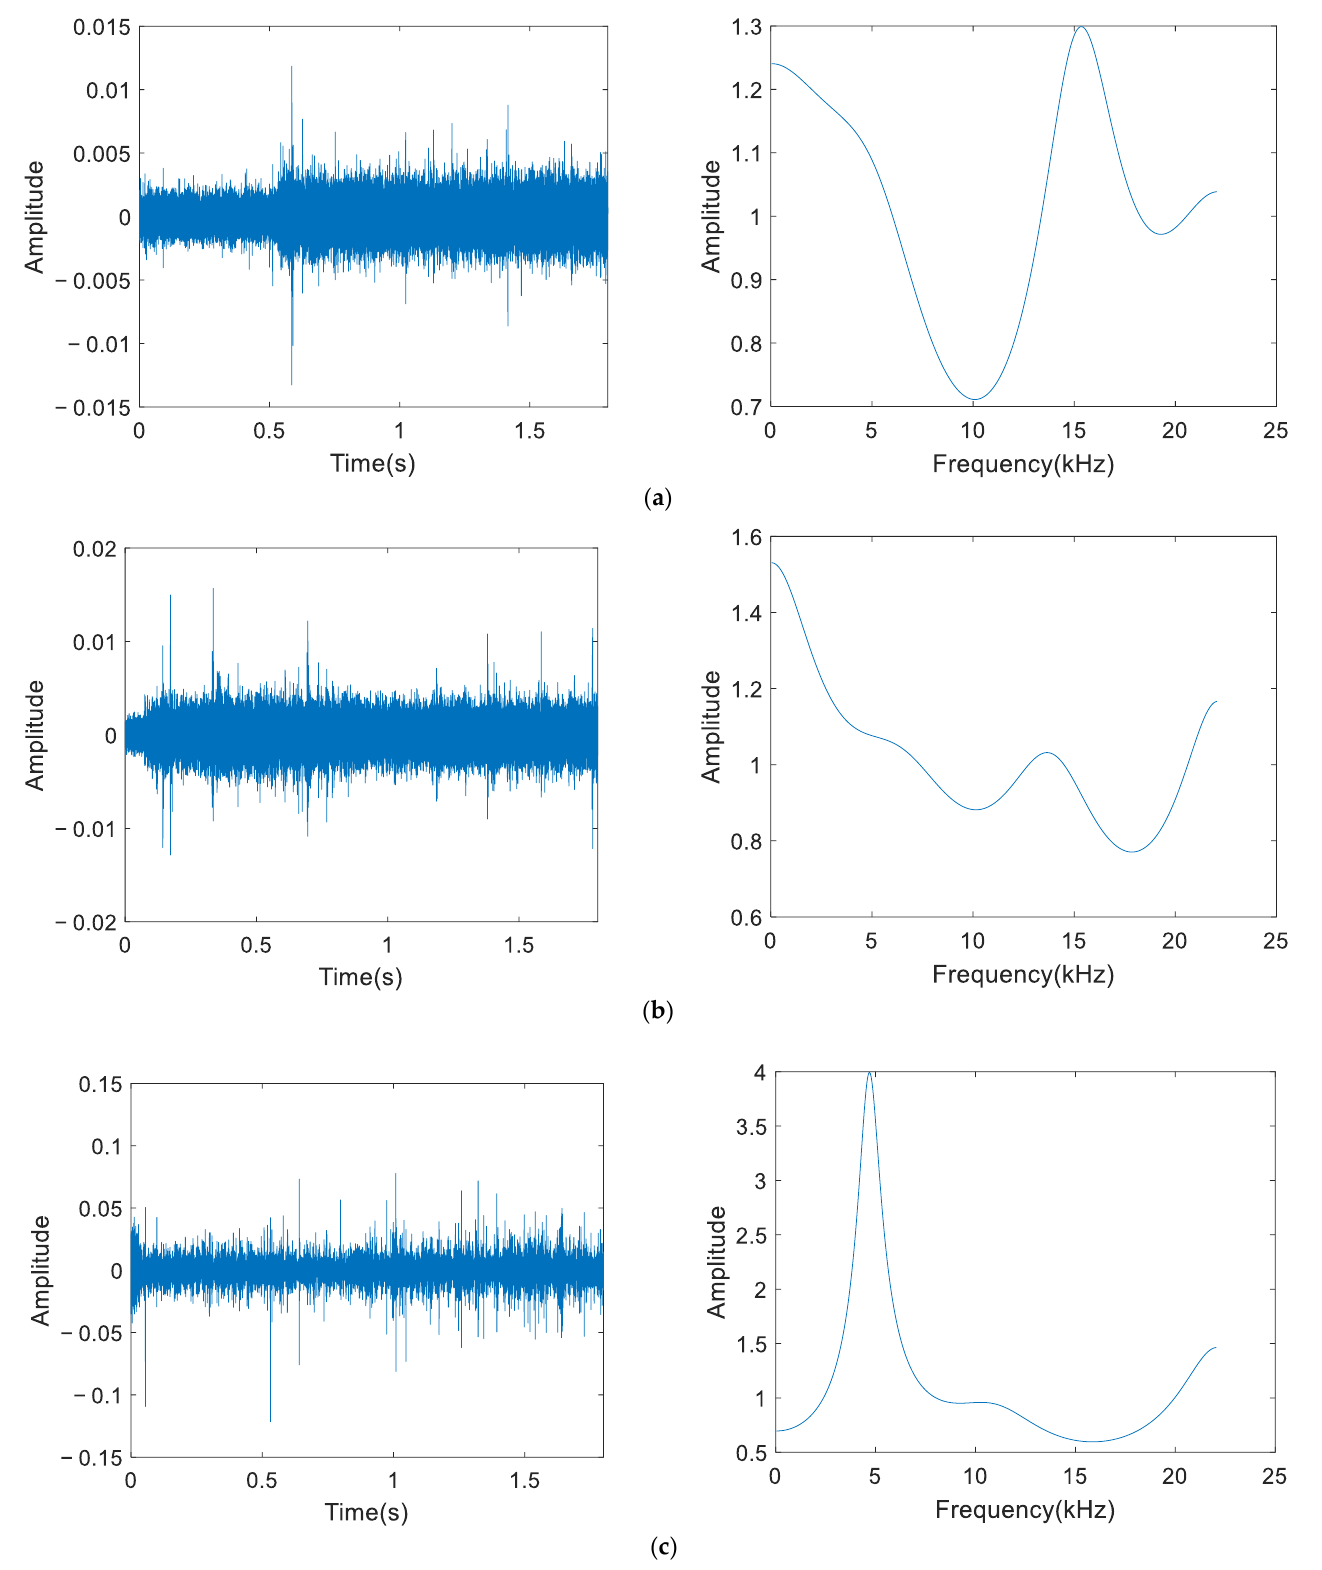
Figure 4. The waveform of the original acoustic signal and the spectrum of linear prediction: ( a ) normal operation of the upper layer; ( b ) flooding of the upper layer; ( c ) flooding of the lower part.